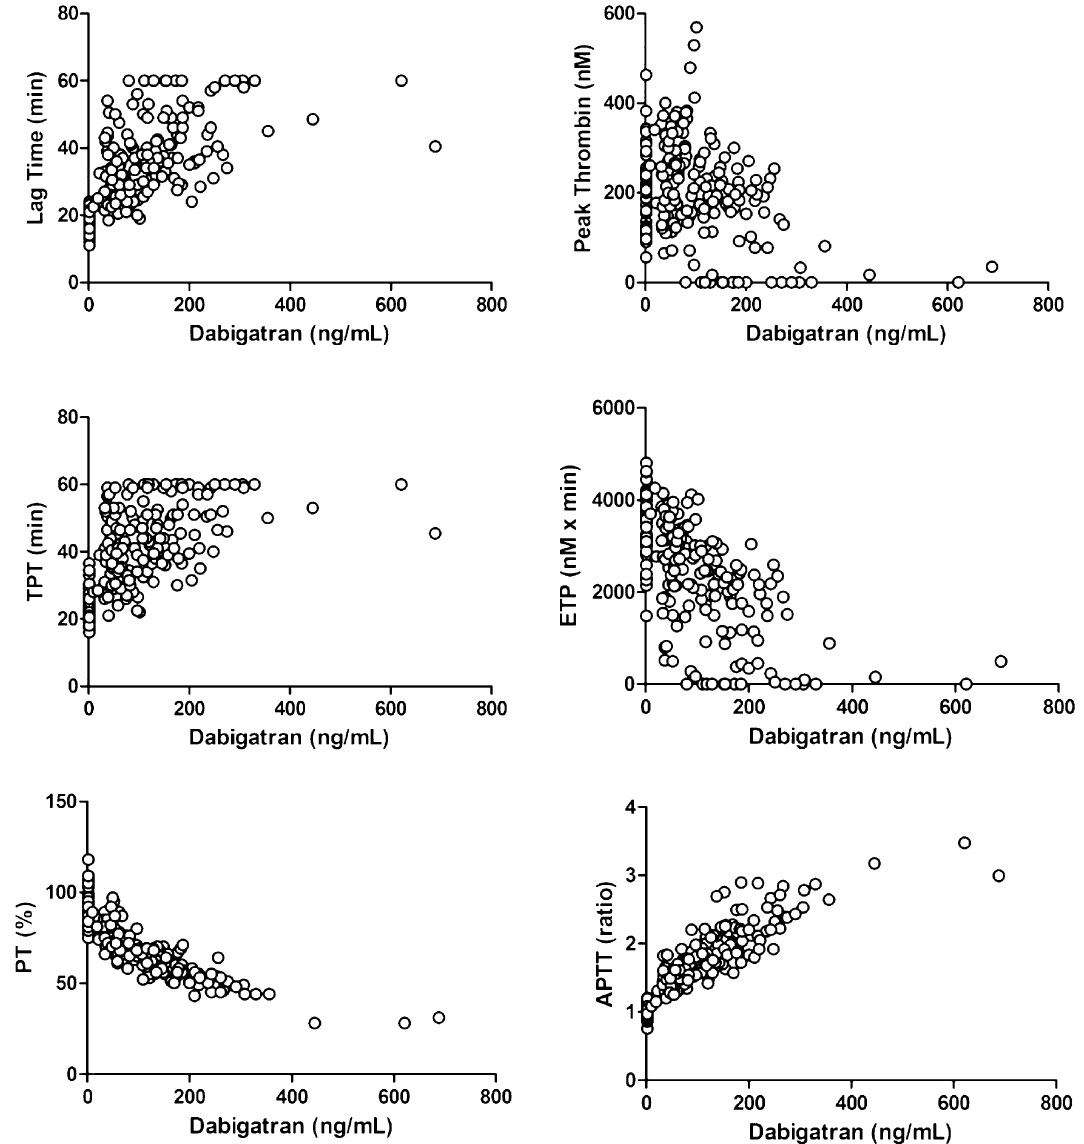
Figure 1. Correlations between dabigatran concentration and TGA (Lag Time, Peak Thrombin, TPT and ETP), PT and APTT. TGA Thrombin Generation Assay, TPT time to peak thrombin, ETP Endogenous Thrombin Potential, PT Prothrombin Time, APTT Activated Partial Thromboplastin